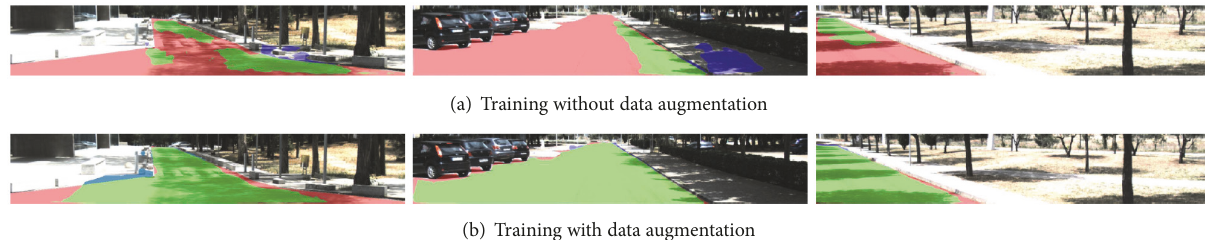
Figure 7: The qualitative results of the proposed model are coloured as follows: TP in green, FP in blue, and FN in red. The scenarios with strong illumination changes and challenging road textures are better detected in the model trained with data